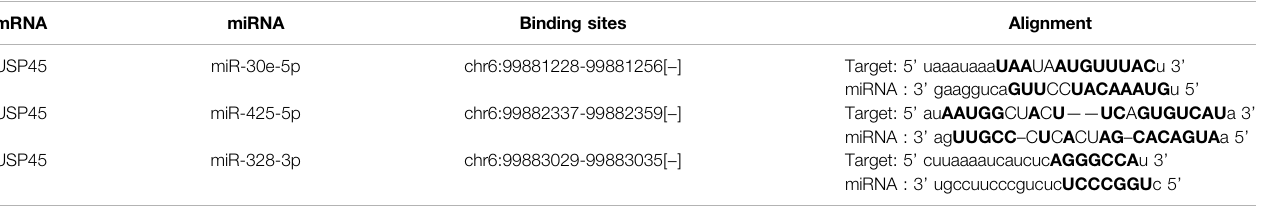
TABLE 2 | The predicted miRNAs which may target to the 3 ’ UTR of USP45 mRNA.